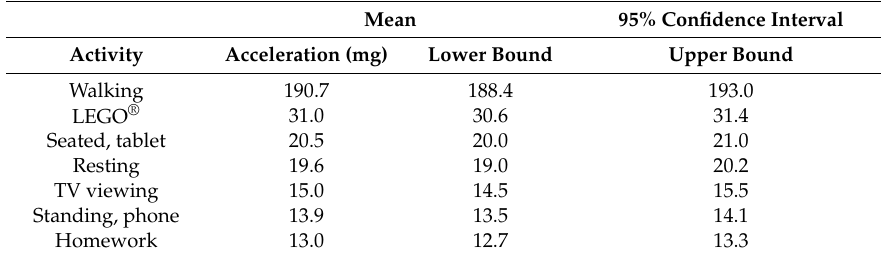
Table 3. Mean accelerometer output from both brands and wrists, for all activities, from highest to